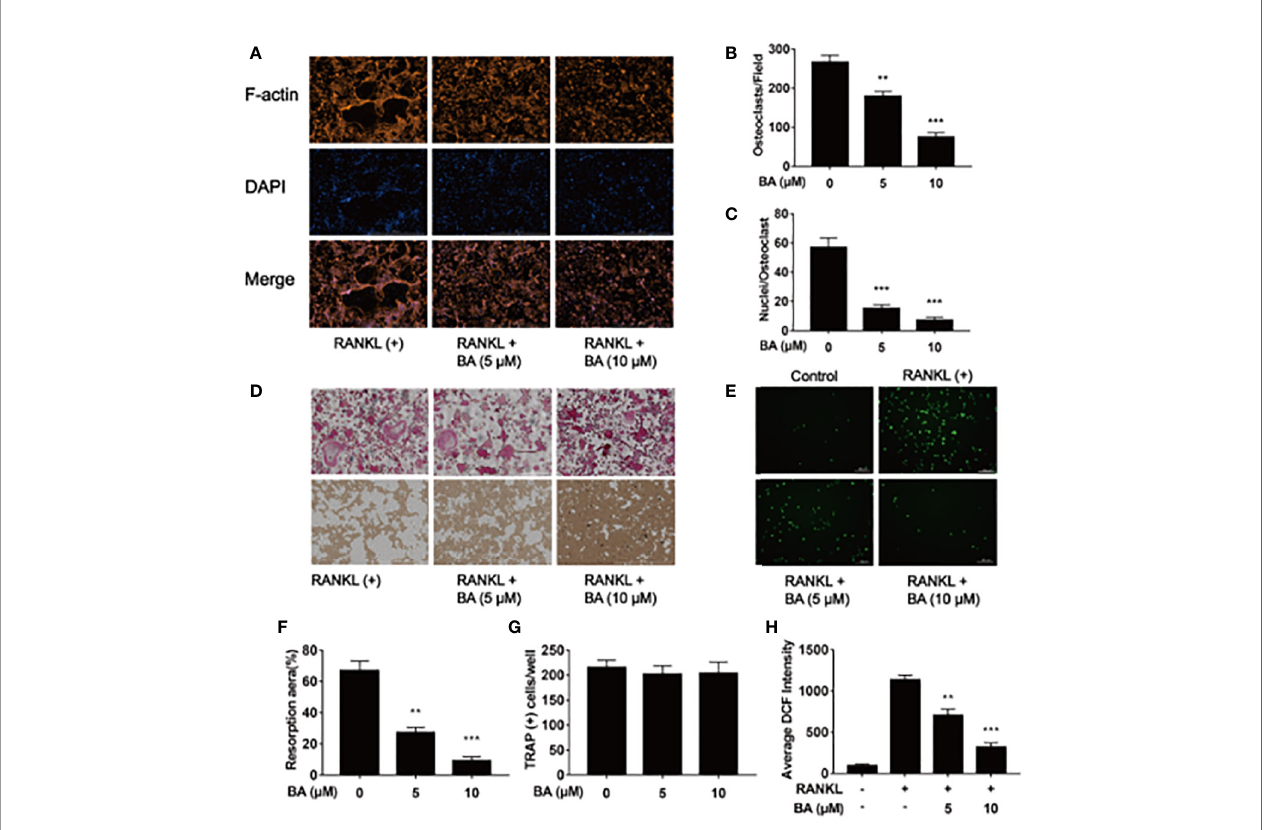
FIGURE 2 | BA restrains F-actin belt formation and osteoclastic hydroxyapatite resorption triggered by RANKL while decreasing ROS levels in BMMs. (A) Representative images of formed F-actin belts as assessed by immuno fl uorescent staining with DAPI counterstaining. (B) Mean F-actin belt areas (n = 3). (C) Numbers of nuclei per osteoclast. (D) Representative micrographs of TRAP stained osteoclasts on hydroxyapatite coated plates. (E) Representative images for ROS production in presence or absence of BA in RANKL-treated BMMs. (F, G) Numbers of osteoclasts and areas of bone resorption assessed by the ImageJ software. (H) DCF intensities per cell indicating ROS levels. Data are mean ± SD. **p <0.01, ***p <0.001 vs. RANKL-induced control group (no BA administration). Scale bar = 1,000 m M, BA, Betulinic acid; DAPI, 4 ′ ,6 ‐ diamidino ‐ 2 ‐ phenylindole; F-actin, fi brous